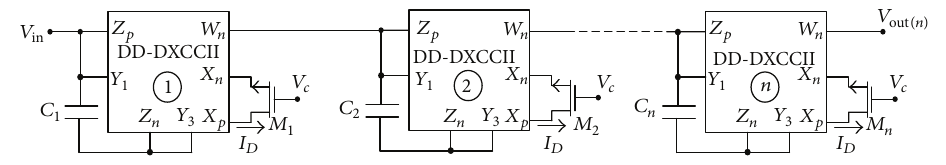
Figure 4: Proposed tunable 𝑛 th order all-pass filter.